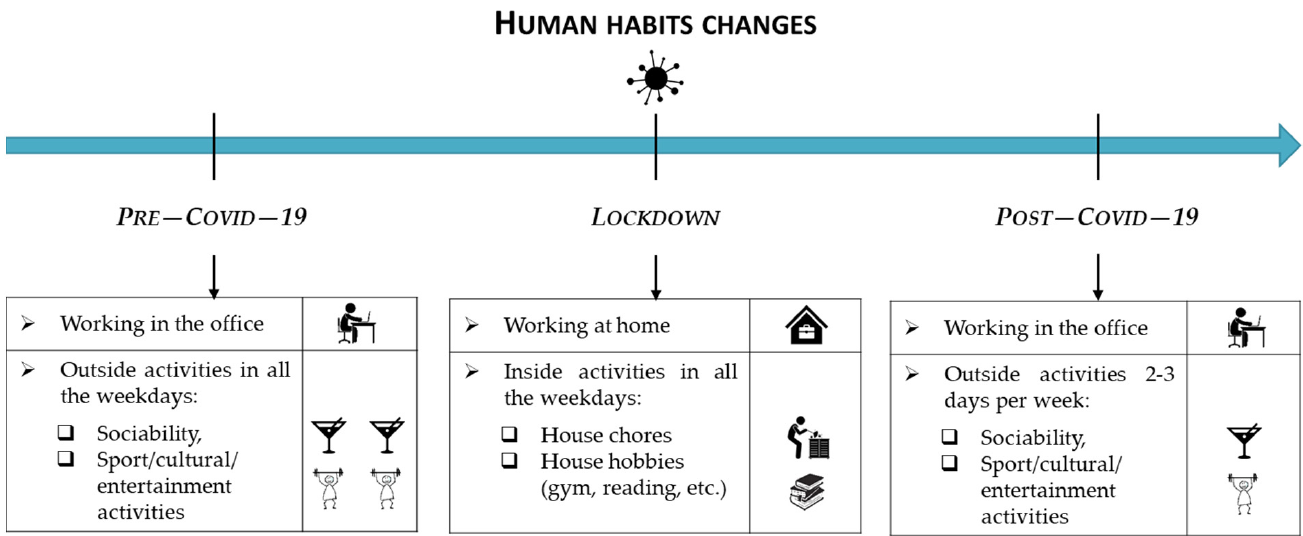
Figure 1. Change of human habits before, during, and after the COVID-19 pandemic.